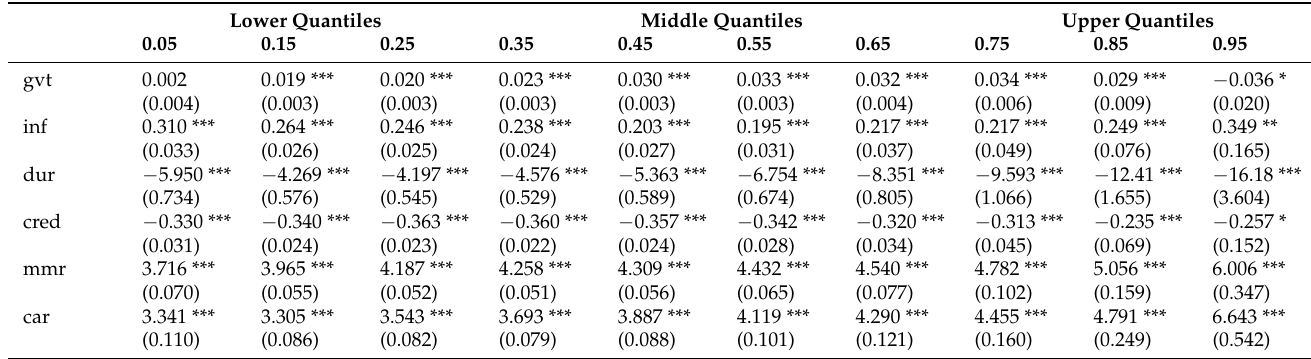
Table 5. Panel Conditional Quantile Regression—Robustness Analysis Using Daily USD Returns as a Proxy for Bond Price